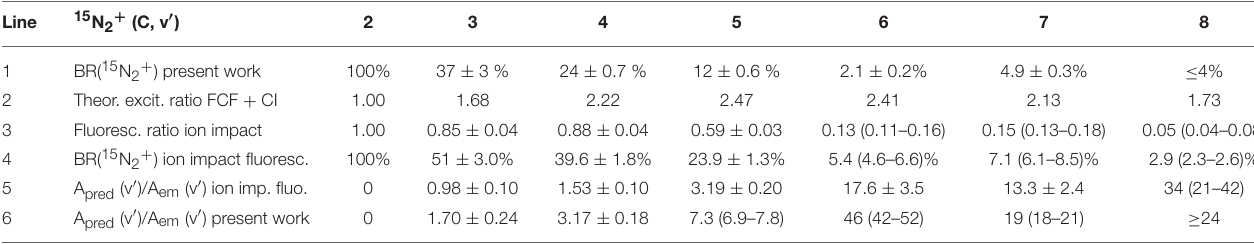
X fluorescence → 2–8 of the C 2 6 + u state of 15 N 2 + . =